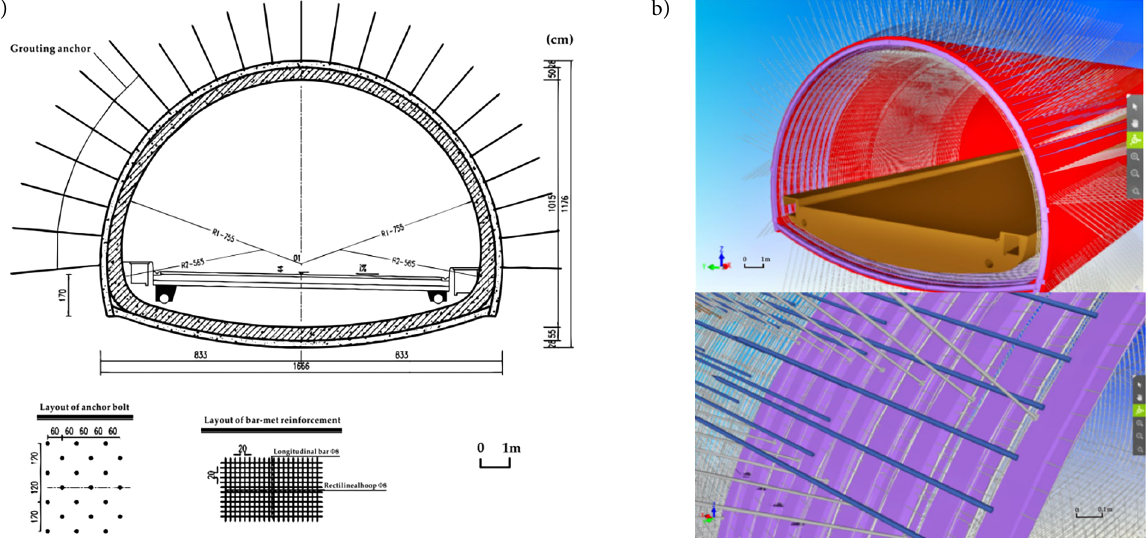
Figure 8. Methods of technological explanation in construction: a – a traditional 2D drawing only shows the entity briefly; b – a 3D visualization model shows more details and vividly expresses the entity